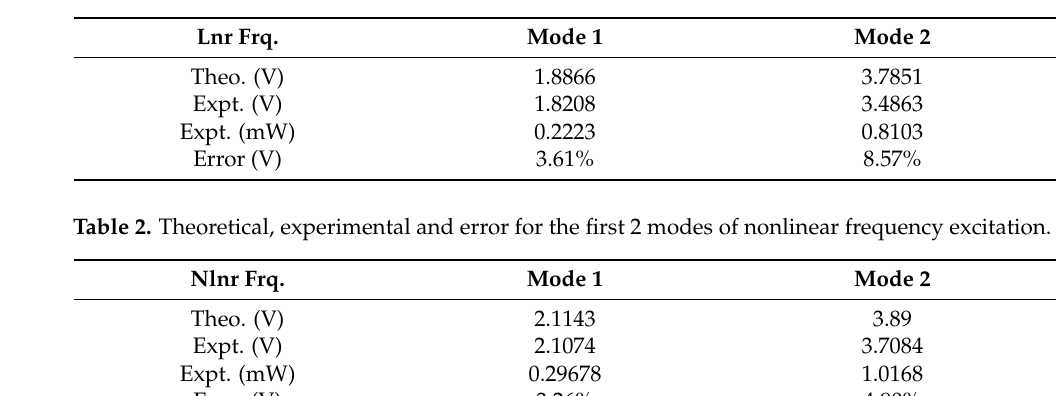
Figure 17. Experimental voltage output for “nonlinear” frequency excitation. ( a ) 1st mode, ( b ) 2nd mode. Table 1. Theoretical, experimental and error for the first 2 modes of linear frequency excitation.